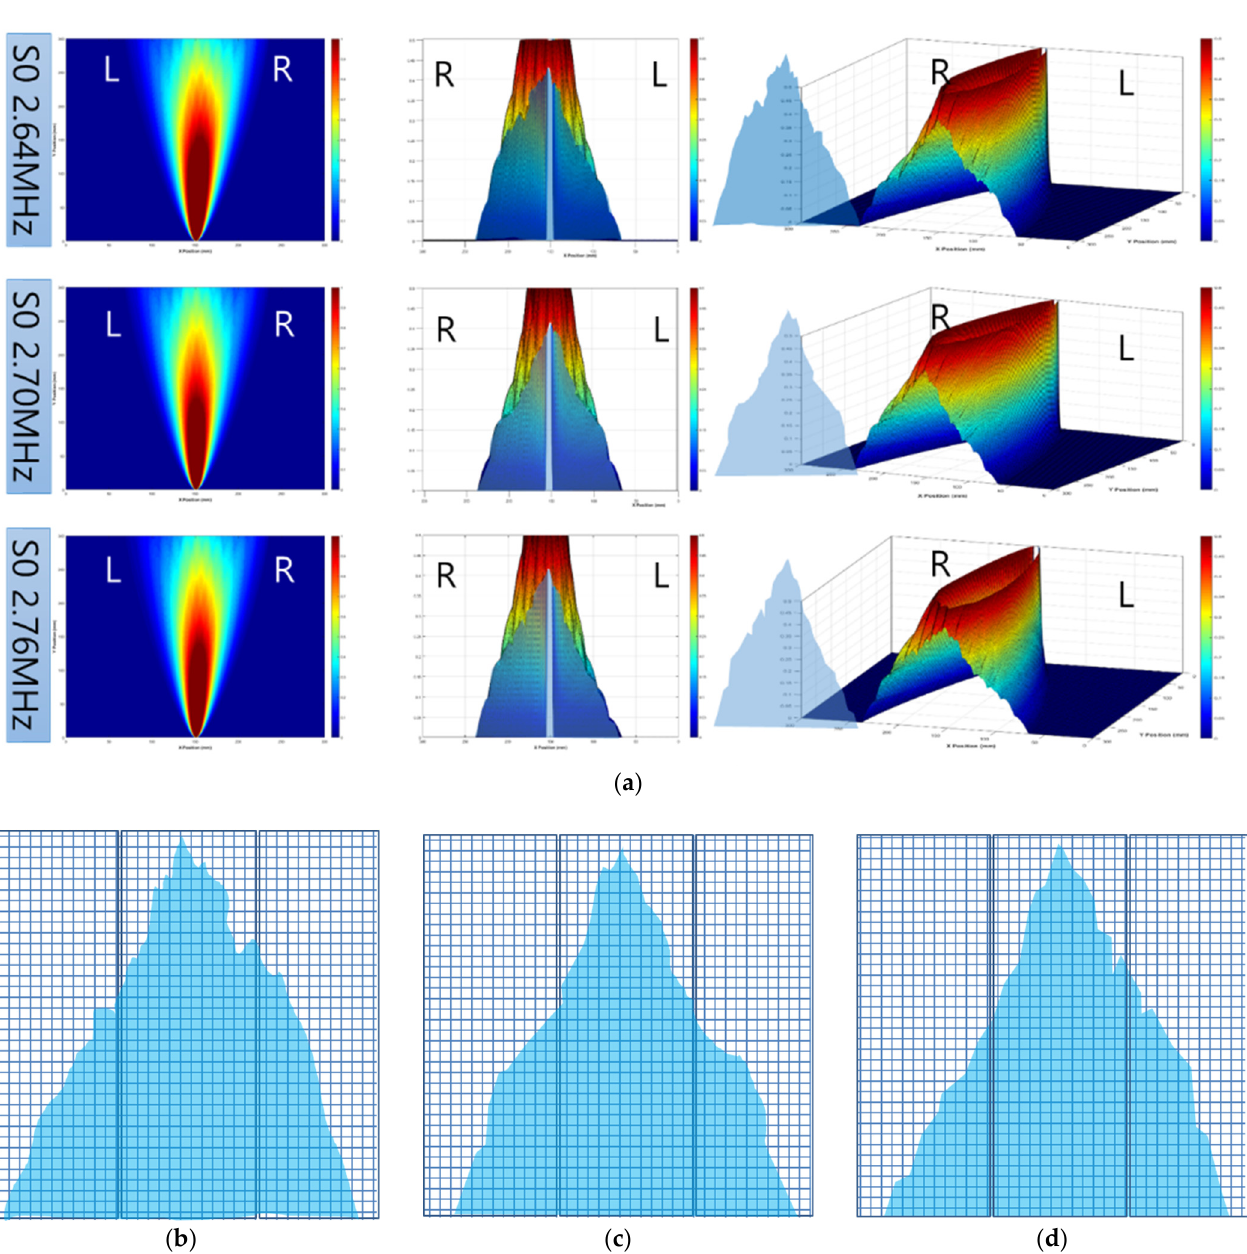
Figure 13. The concept of beam energy distribution and skewing analysis.